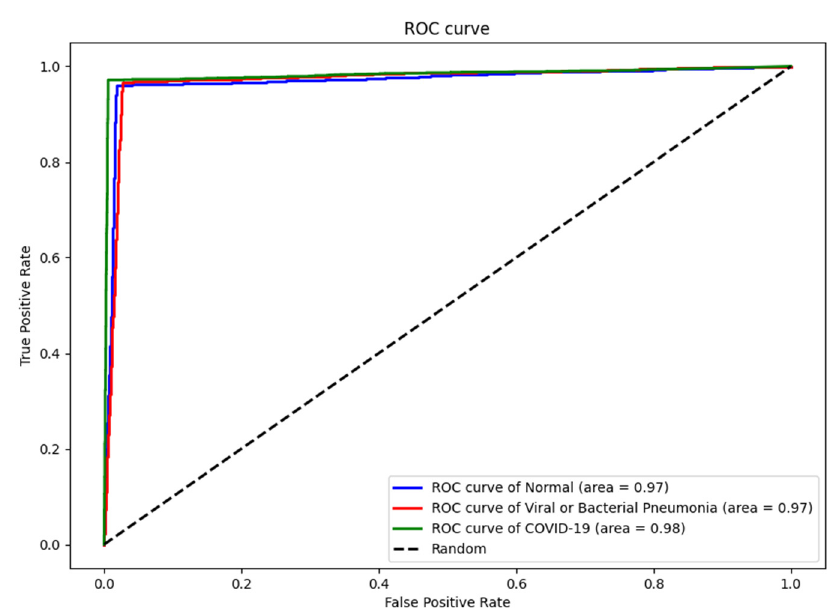
Figure 11. Confusion matrix for the VGG19 model on the test dataset.